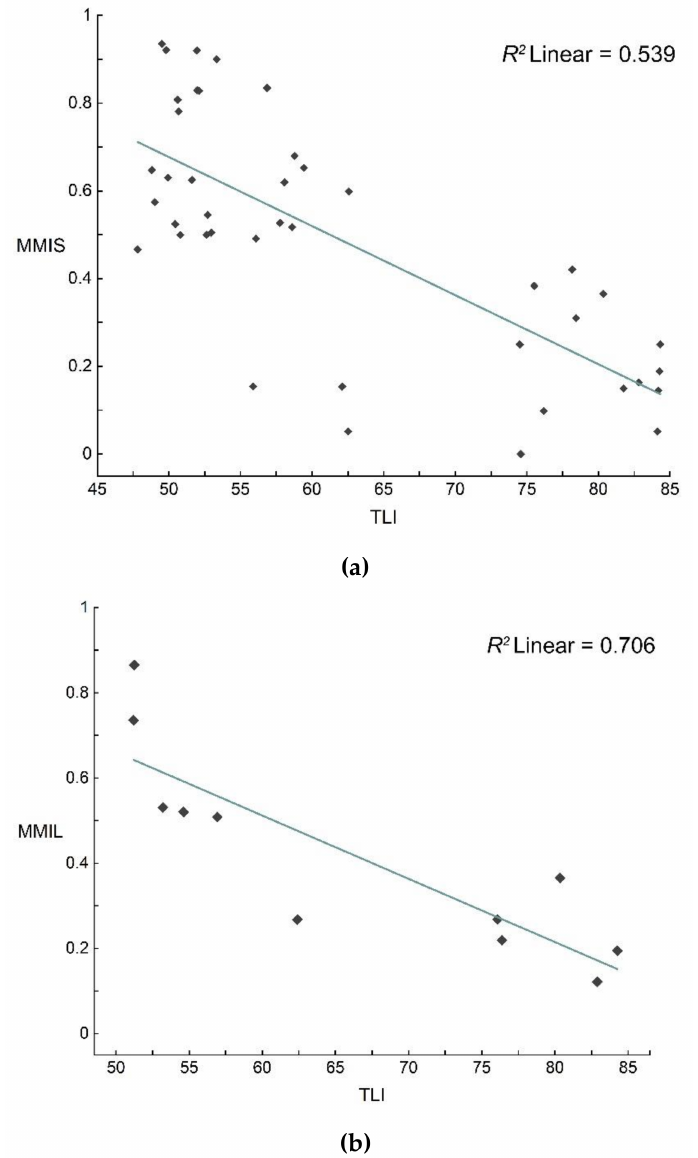
Figure 5. Scatter plot of fitted line: R 2 represents the fitting degree between the point and the line ( a ) MMI value of site (MMIS) and TLI value, ( b ) MMI value of lake (MMIL) and TLI